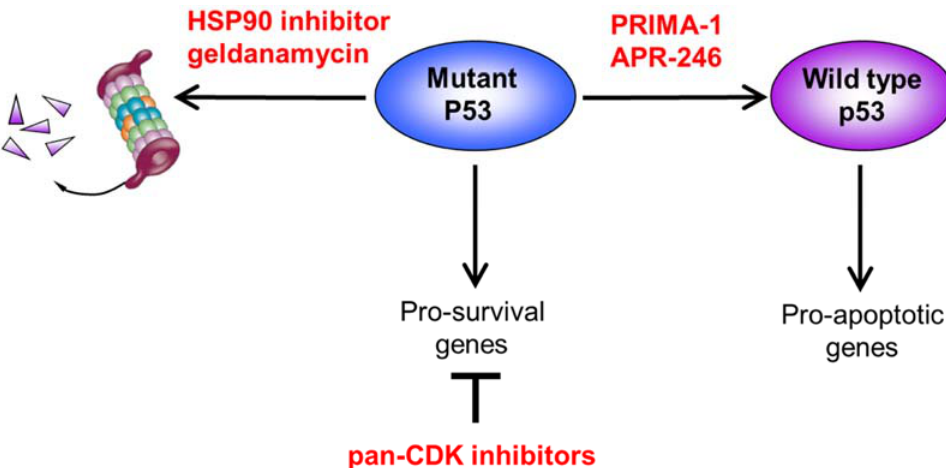
Figure 2. Strategies to restore the tumor-suppressive function of mutant p53. Wild-type p53 regulates the transcription of proapoptotic genes. In response to DNA damage, mutant p53 fails to activate proapoptotic genes. p53-independent ATM-dependent transcription leads to the activation of strong prosurvival signals. This effect can be counteracted by CDK inhibitors that suppress RNA polymerase II function. Other strategies to restore normal p53 function involve altering the configuration of mutant p53 by PRIMA-1 and APR-246, as well as its proteasomal degradation facilitated by HSP90